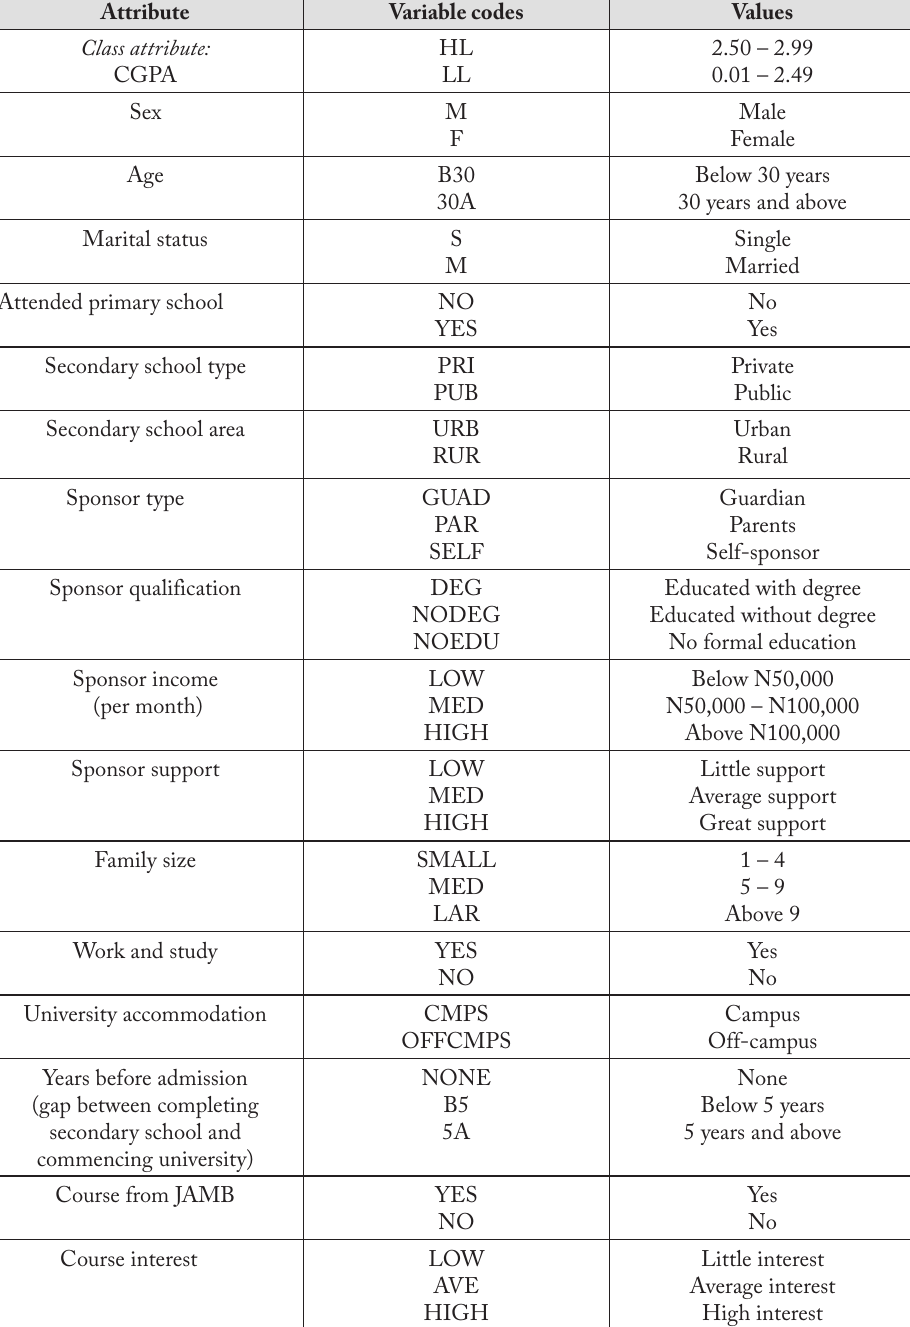
Table 1: The attributes used in the data mining